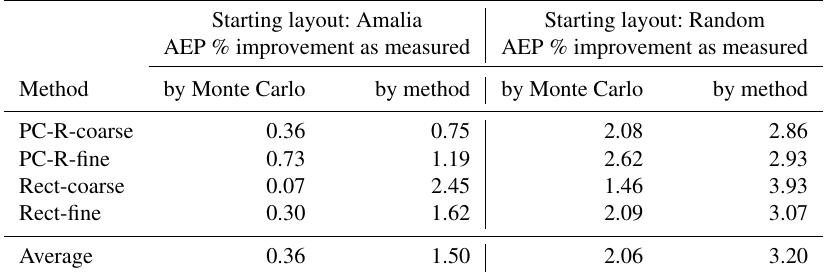
Table 3. The improvement in AEP of the optimized layouts from Fig. 10 over their starting layouts. The improvements are smaller when measured by 200000 Monte Carlo samples rather than directly by the method used to compute the AEP in the optimization. Starting layout: Amalia Starting layout: Random AEP % improvement as measured AEP % improvement as measured by Monte Carlo by method by Monte Carlo by